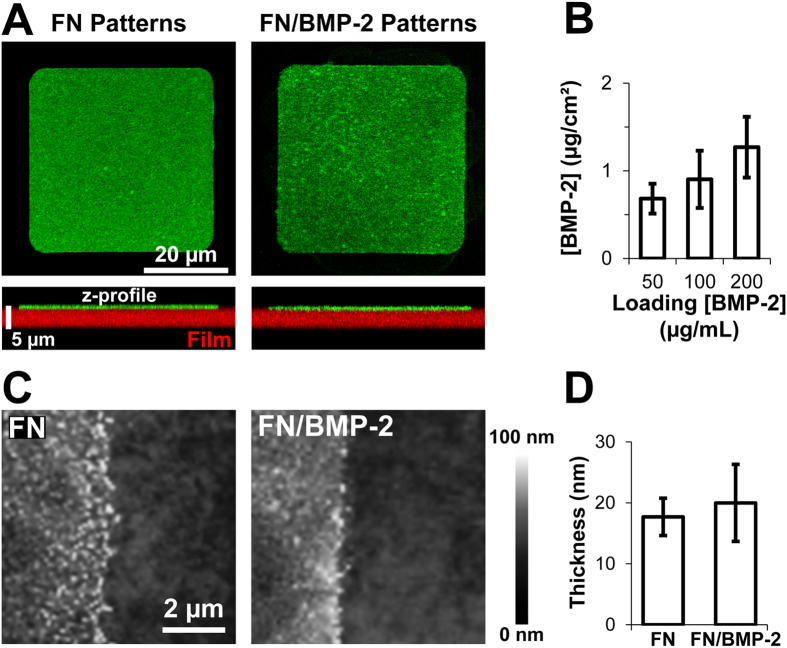
Characterization of the micropatterns.(A) Confocal images and cross-sections of micropatterns of FN (containing 10% of fibrinogenA488) and FN/BMP-2CF. The patterns are in green and the film in red (for the cross-section only). (B) Printed amounts of BMP-2 in micropatterns of FN/BMP-2 in function of the loading concentration of BMP-2 on the stamp. (C) High resolution AFM topography images and (D) thickness measurements of the protein layer on the border of micropatterns (located on the left of each image).